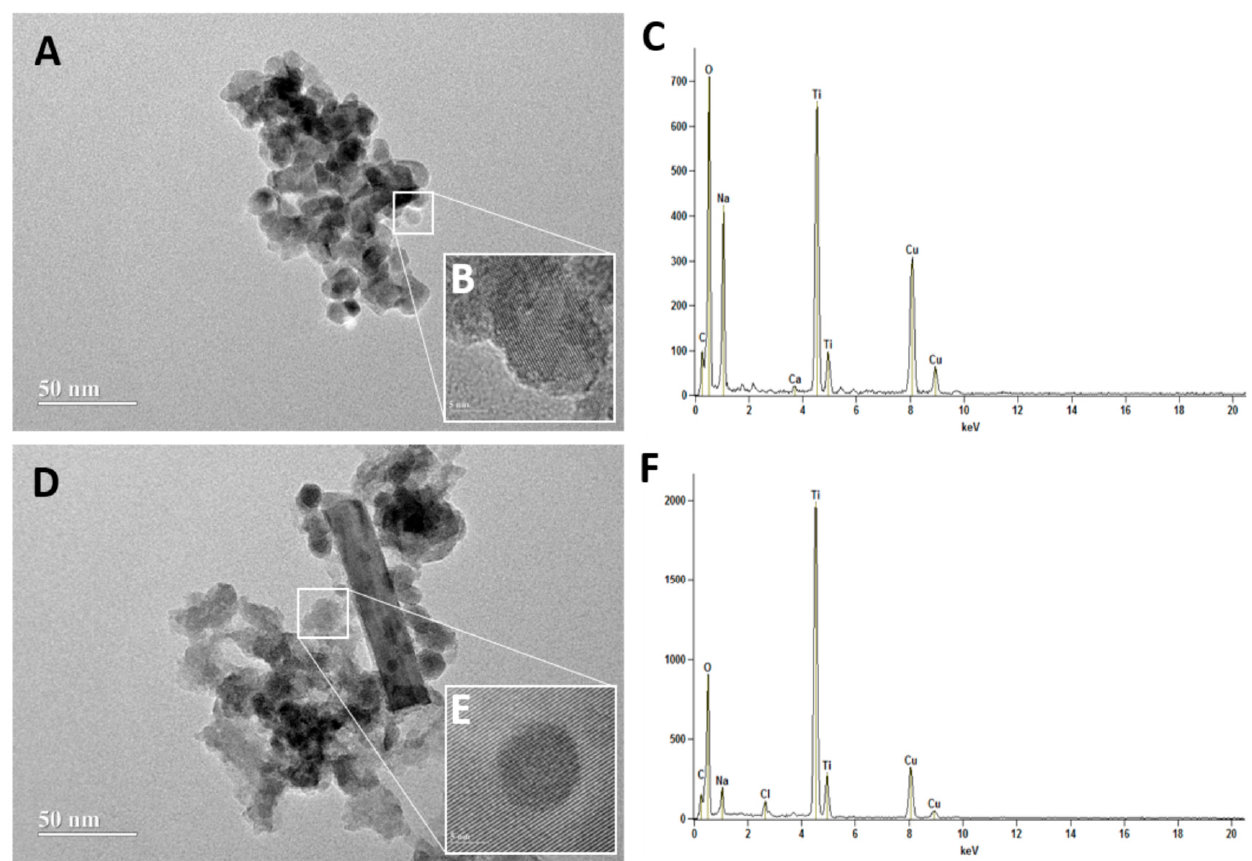
Figure 2. Transmission Electron Microscopic (TEM) image of TiO 2 ( A , B ) and Eu 3+ -doped TiO 2 (TiO 2 :Eu) nanocrystals ( D , E ). Scale bar = 50 nm ( A , D ) and 5 nm ( B , E ). The Energy Dispersive X-Ray Spectroscopy (EDS) of TiO 2 ( C ) and Eu 3+ -doped TiO 2 (TiO 2 : Eu) nanocrystals ( F ) representing the elemental composition of nanocrystals.